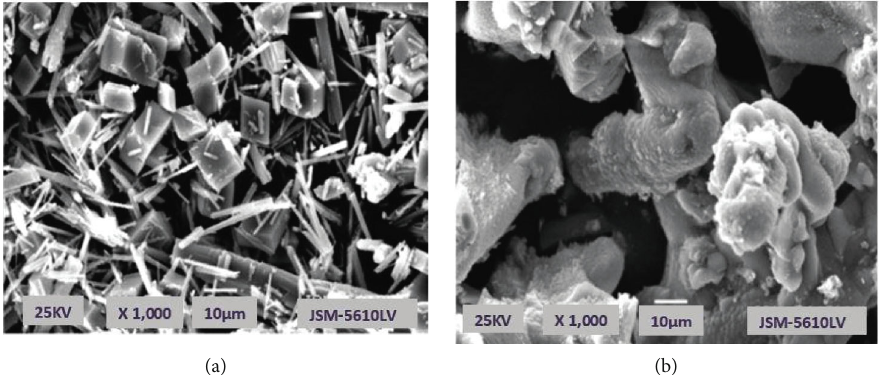
Figure 14: SEM analysis images of calcium carbonate scale (a) without CNS-PESA and (b) with adding CNS-PESA.